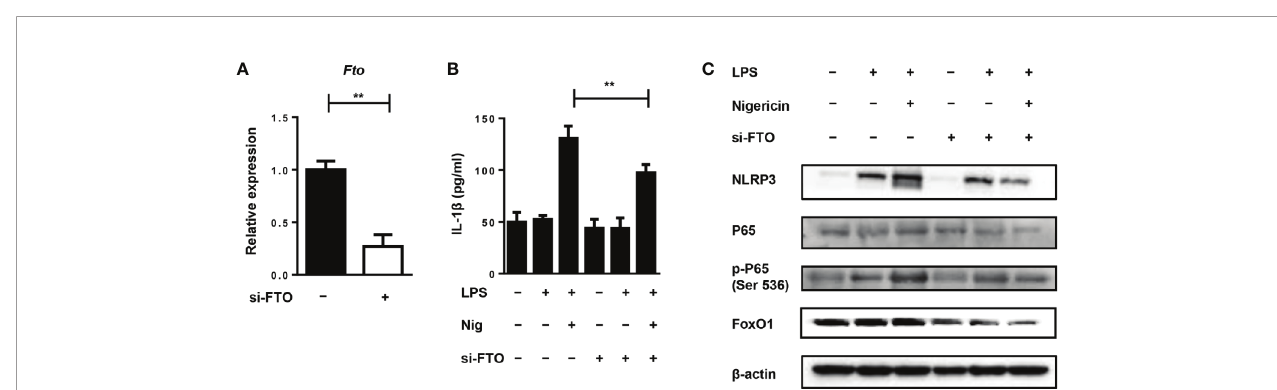
FIGURE 5 | Silencing of Fto inhibits NLRP3 in fl ammasome-mediated IL-1 b secretion through FoxO1/NF- k B signaling pathway in macrophages. (A) qPCR results showed treatment of Fto- siRNA down-regulated target genes at the mRNA level. (B) BMDMs were pre-incubated with Fto -siRNA or ctrl- siRNA and the NLRP3 in fl ammasome activation was induced by the treatment of LPS and nigericin. The concentration of IL-1 b in culture medium was measured by ELISA. (C) Immunoblot analysis of NLRP3, p65, phospho-p65 (Ser 536) and FoxO1 expression in BMDMs stimulated with LPS and nigericin. b -actin was used as a loading control. Data are shown as mean ± SEM; **P < 0.01 (two-tailed unpaired